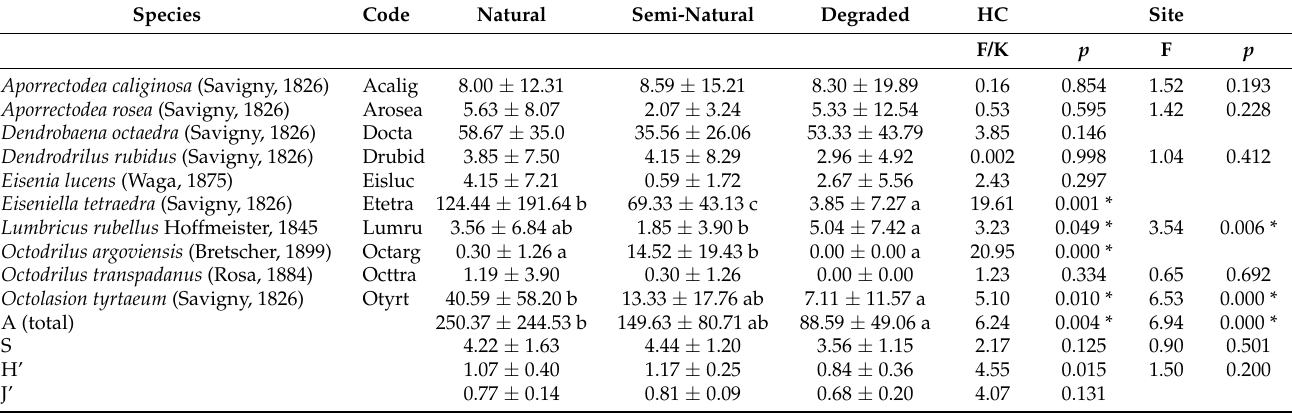
Table 4. Effect of hydrologic conditions (HC) and fen sites on the species of Lumbricidae and community metrics: species mean abundance and total abundance A (ind. m 2 ), species richness (S), Shannon diversity index (H’) and Pielou evenness index (J’). Two-way nested ANOVA model was calculated with log 10 (x + 1)-transformed data except for (H’) and (J’) indices (HC–d.f. = 2; sites d.f.